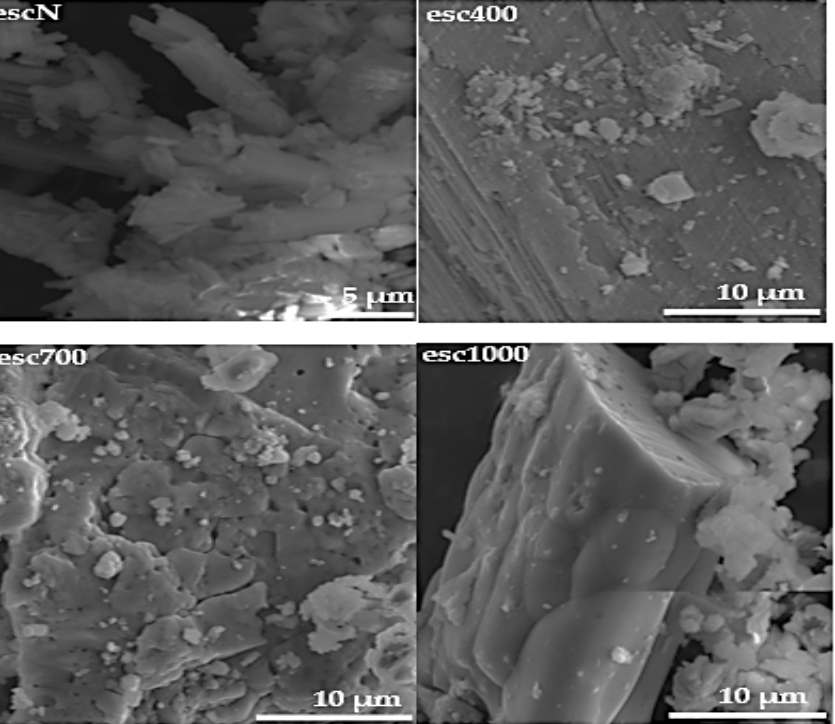
Figure 2. DTG-TG of ( a ) escN, ( b ) esc400, ( c ) esc700 and ( d ) esc1000.